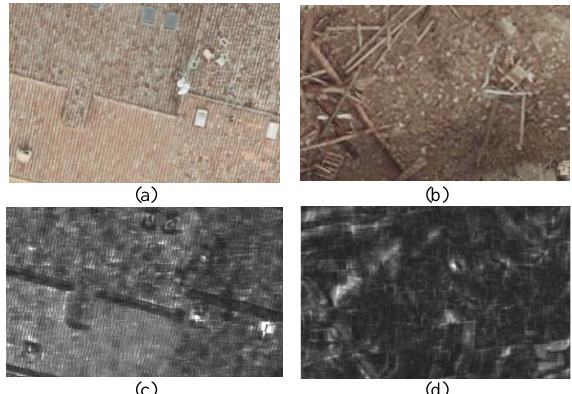
Figure 1. Texture (a) and corresponding spectral feature (c) for a not- damaged roof; texture (b) and corresponding spectral feature (d) for a damaged